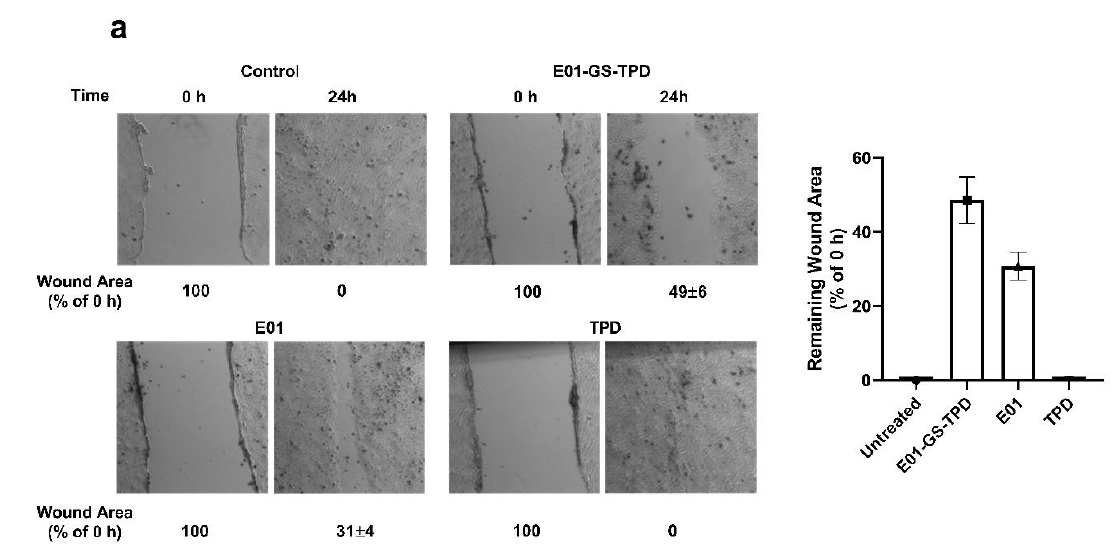
Appendix Figure B1. E01-GS-TPD inhibits A431 cell migration. Scratches were made in confluent A431 cultures to create a visible wound in the cell monolayer. Cultures were treated with recombinant protein at a final concentration of 0.5 µM for 24 h and the remaining wound area was compared to the initial wound at 0 h ( a ). The remaining wound area for each condition was then calculated to determine the effects of each protein on cell migration ( b ). Mean and standard deviation from n = 2 is shown.